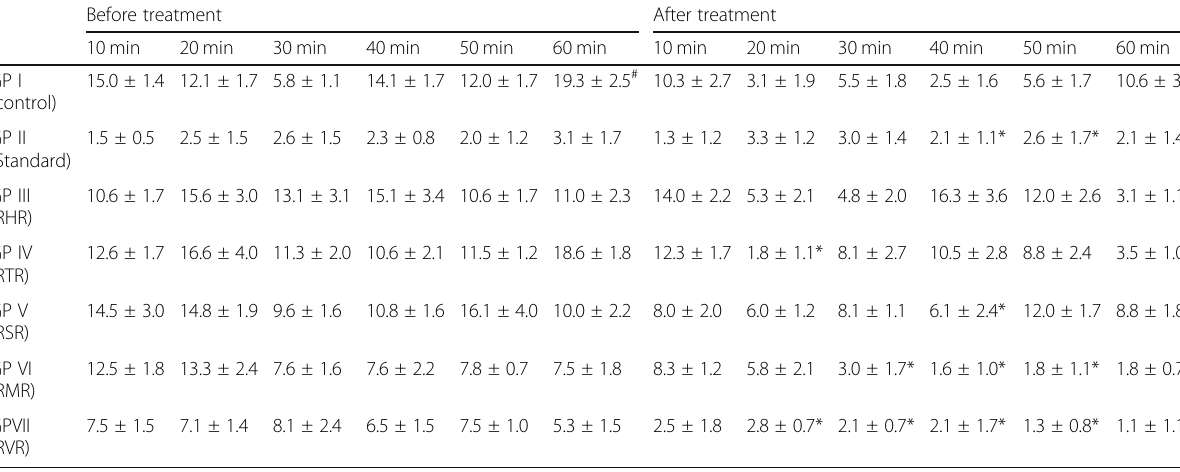
Table 7 analgesic activity of various Rauvolfia species by formalin test Before treatment After